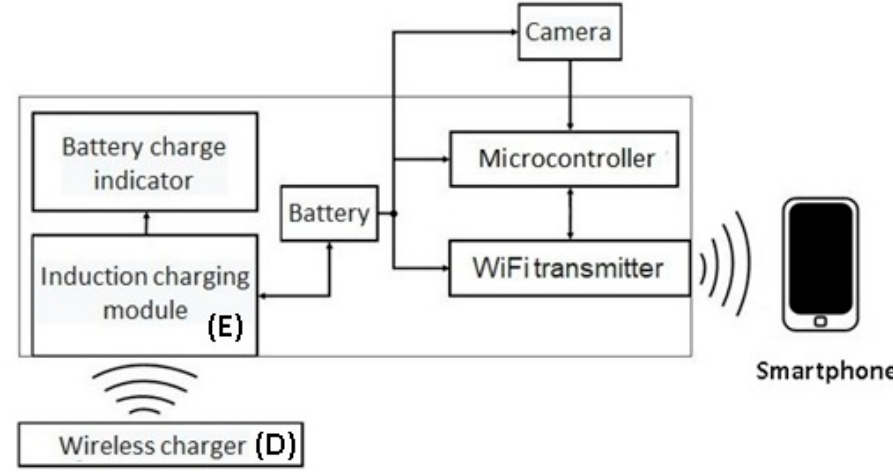
Figure 2. Block diagram of the charging and wireless communication with a smartphone.